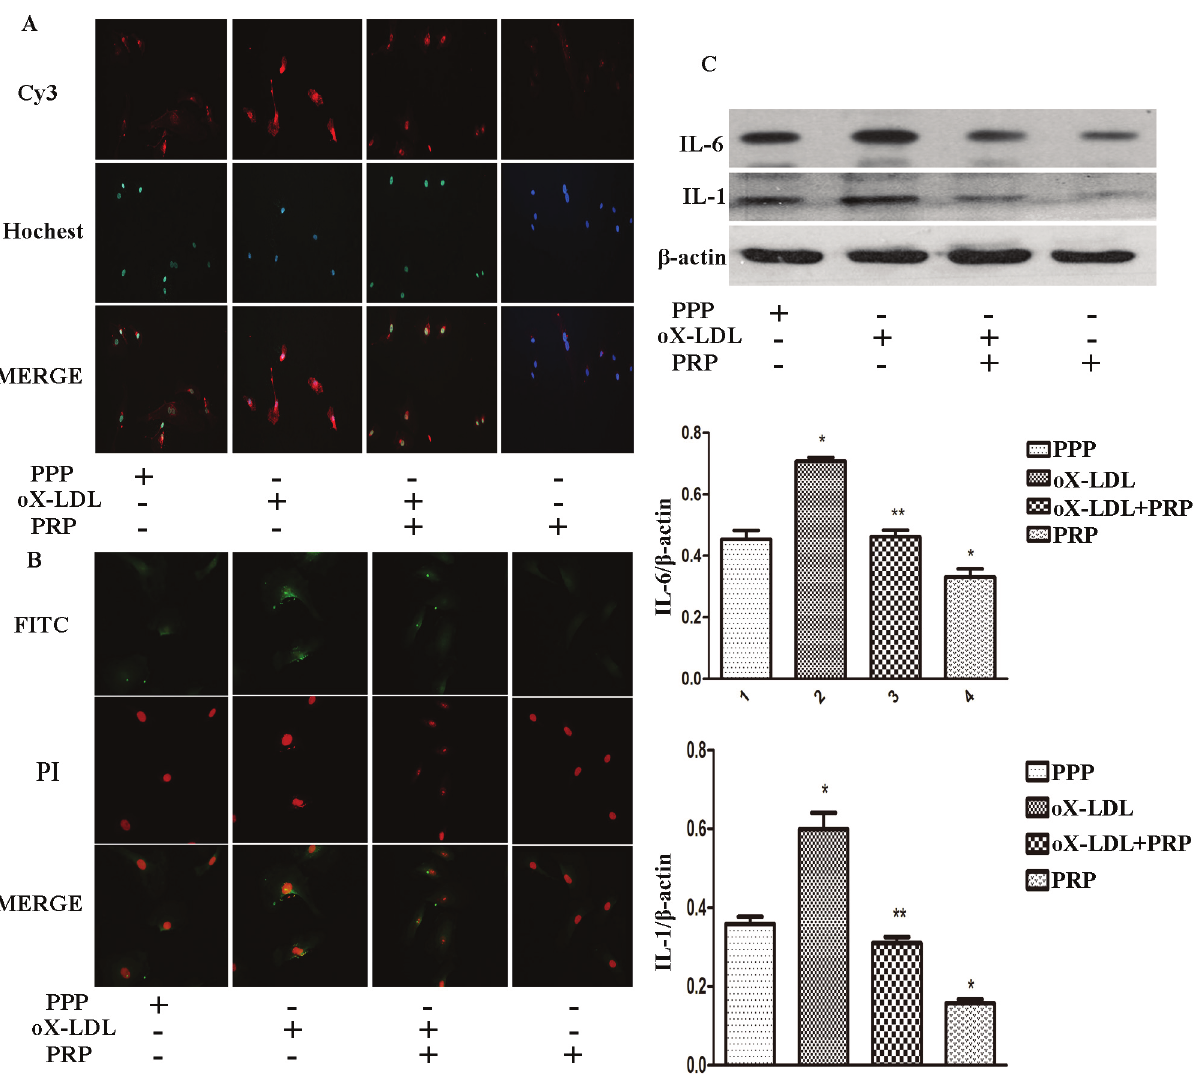
Figure 5: IL-6 and IL-1 expression in four different groups. Secondary antibodies conjugated with Cy3 or FITC were used to detect IL-6 and IL-1, respectively. Cell nuclei were stained by Hochest 33342 and PI. A: IL-6 expression via immunofluorescence. B: IL-1 expression via immu- nofluorescence. C: IL-6 and IL-1 expression detected by western blotting (mean ± SD). *p<0.05 versus control; **p<0.05 versus